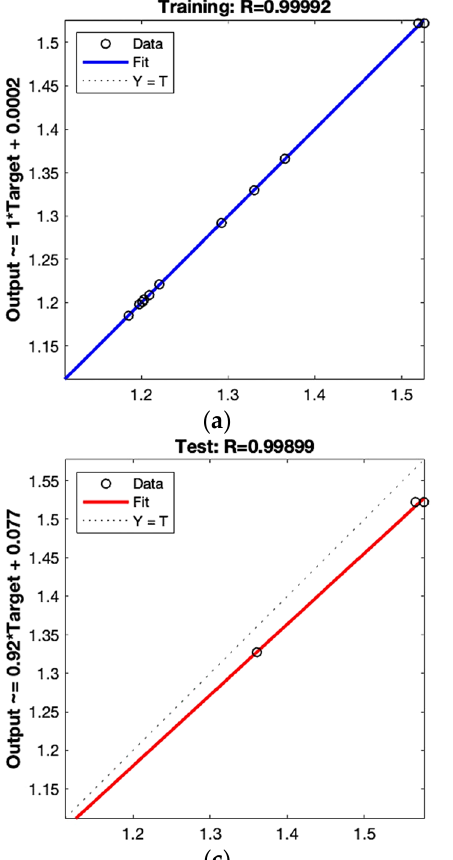
Figure 7. Scatter plot of test data (target) compared with the computed neural network data in the training set ( a ), validation set ( b ), test set ( c ), and all sets ( d ).